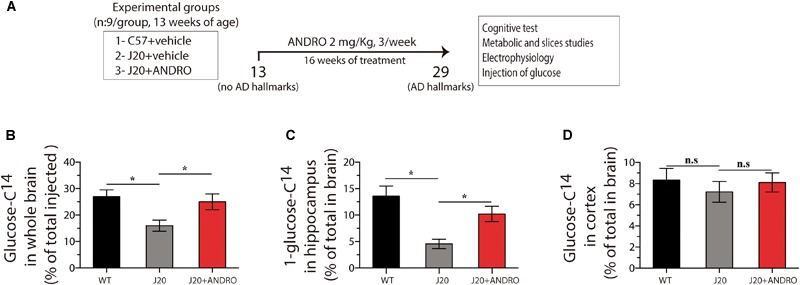
Treatment with ANDRO increases the in vivo uptake of glucose. Schematic of the protocol for assaying the effect of ANDRO administration in a presymtomatic stage (A). After the indicated treatments, radioactive glucose was injected in the tail vein, and 15 min later, glucose uptake in the whole brain (B), hippocampus (C), and cortex (D) was measured. The magnitude of the decrease in glucose uptake was mitigated in J20 mice. ANDRO treatment improved glucose uptake in the J20 animals to levels similar to those of WT mice. Data represent the mean ± SEM of n = 6 (number of animals for treatment), p ≤ 0.05 (95% CI) was considered the threshold for statistical significance, Bonferroni test, p-values are indicated in the “Results” Section.